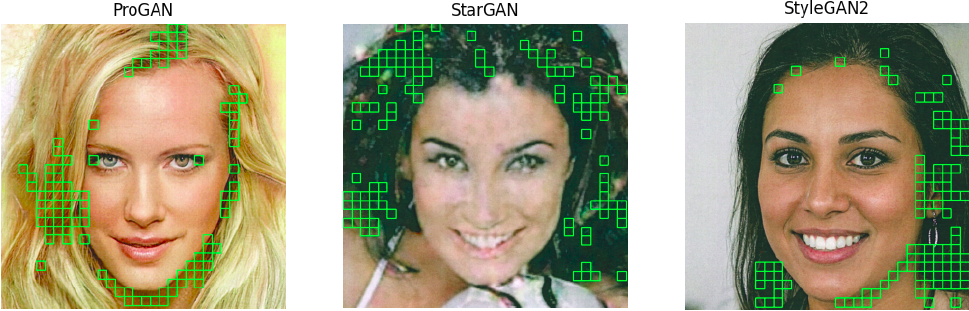
Figure 7. Sample printed pictures from each of the GANs in our dataset with their 64 × 64 top 100 energy